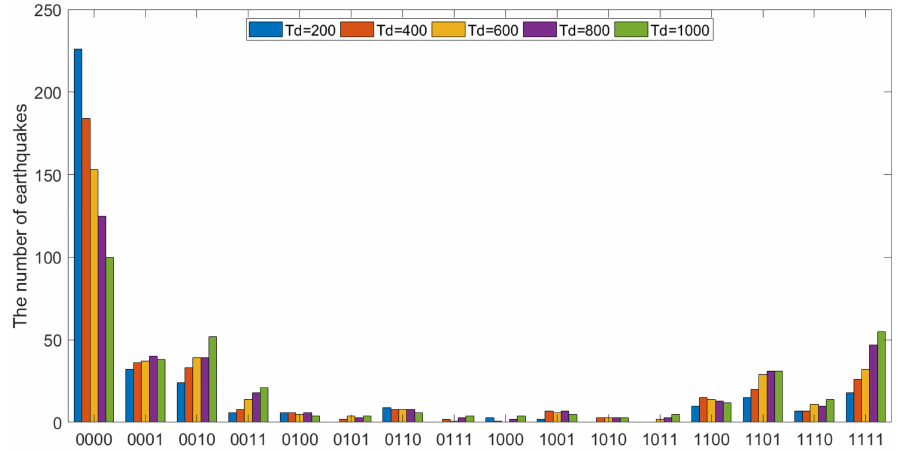
Figure 7. Infrared anomalies before earthquakes.